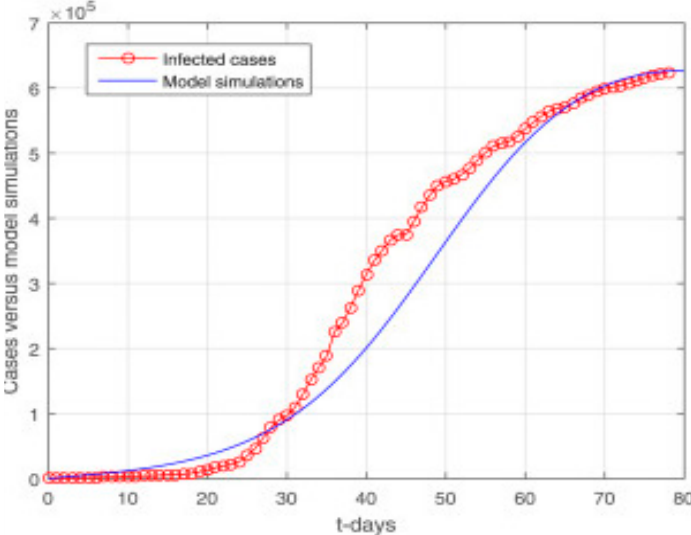
Figure 8. Model fitting using real data.